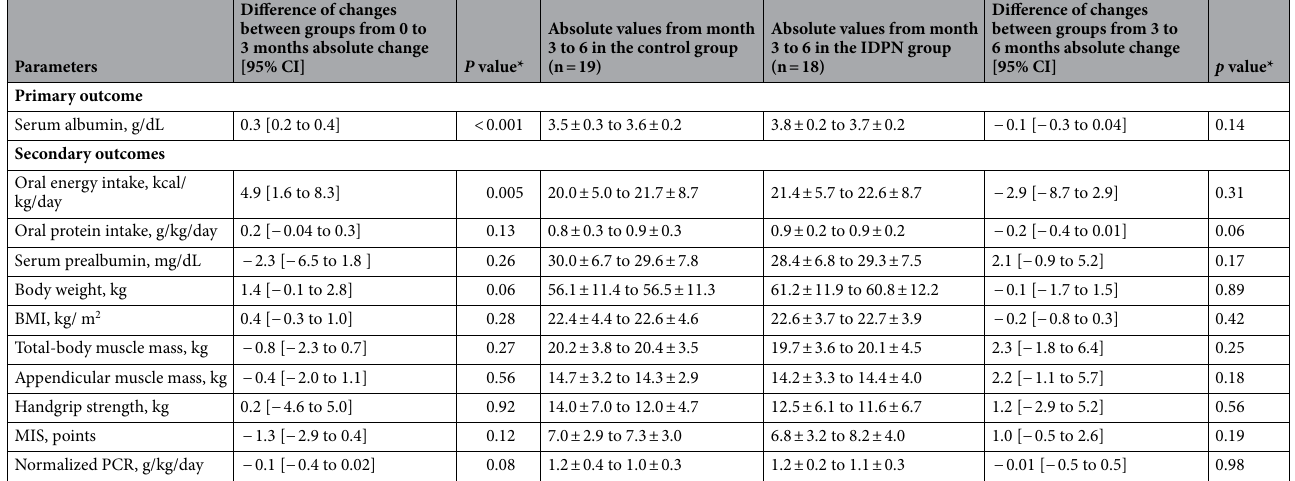
Table 3. Changes of nutritional parameters as continuous variables in the IDPN group compared with the control group (between groups comparison). BMI Body mass index, CI Confidence interval, MIS Malnutrition inflammation score, PCR Protein catabolic rate. * P values for between group comparison of changes using linear regression model. (−) indicated a decrease